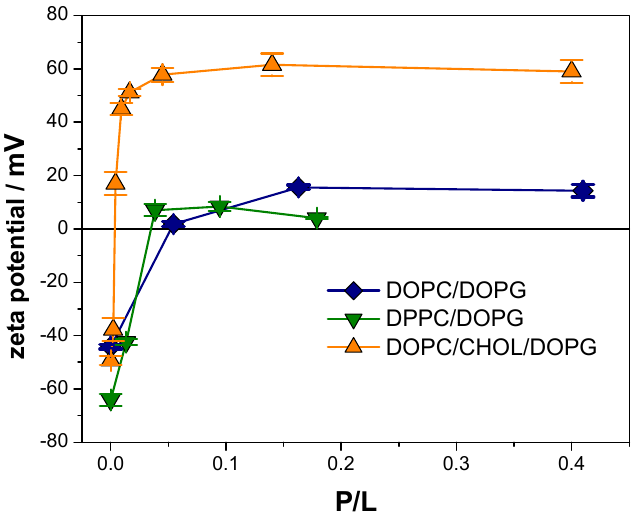
Figure 4. Z-potential values for LUVs of the indicated compositions incubated with increasing concentration of KR 9 C. Average ± SD of two independent experiments.